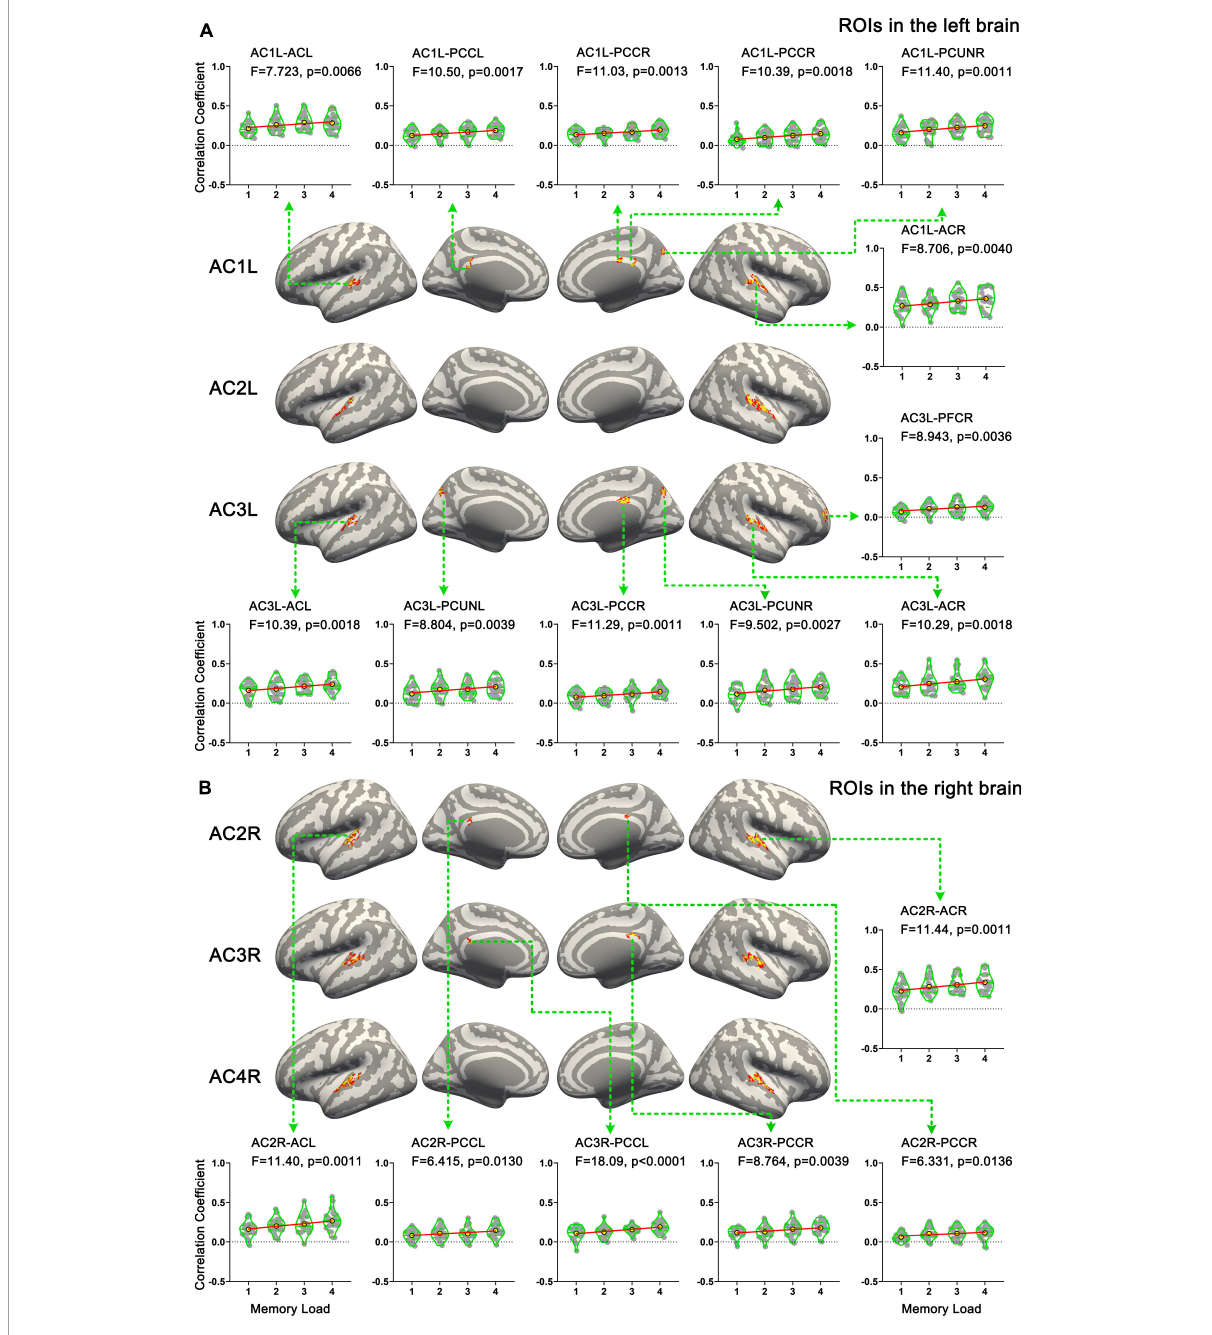
FIGURE7 Results of functional connectivity analysis. (A) Brain areas whose functional connectivity strength with ROIs in the left hemisphere was linearly correlated with memory load. (B) Brain areas whose functional connectivity strength with ROIs in the right hemisphere was linearly correlated with memory load. AC, auditory cortex; PFC, prefrontal cortex; PCUN, precuneus; PCC, posterior cingulate cortex.